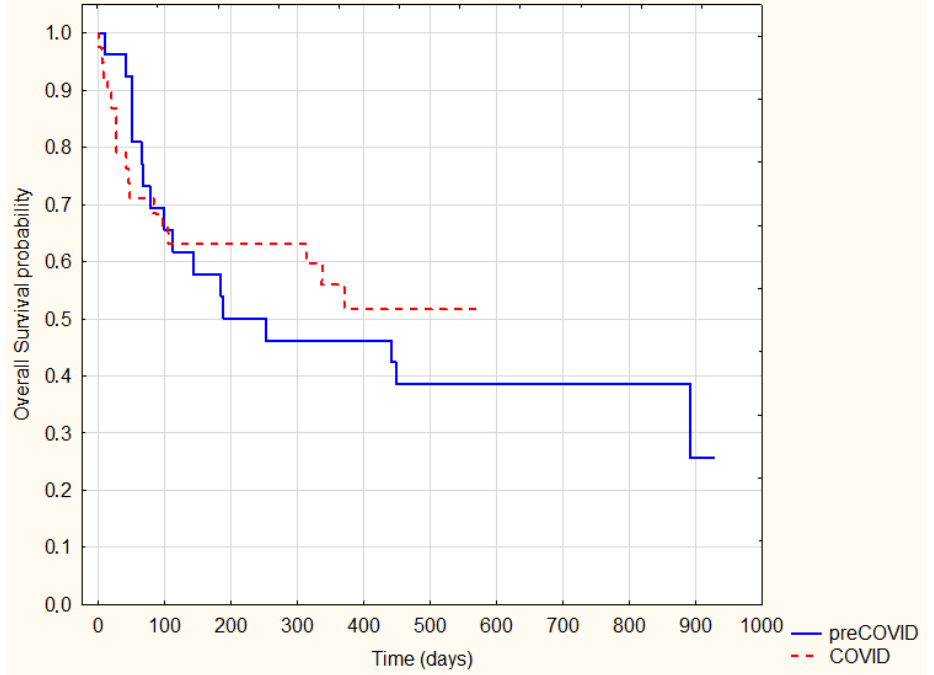
Figure 4. Kaplan–Meier Survival Analysis—radical treatment pre-COVID-19 vs. COVID-19, log-rank p = 0.6.